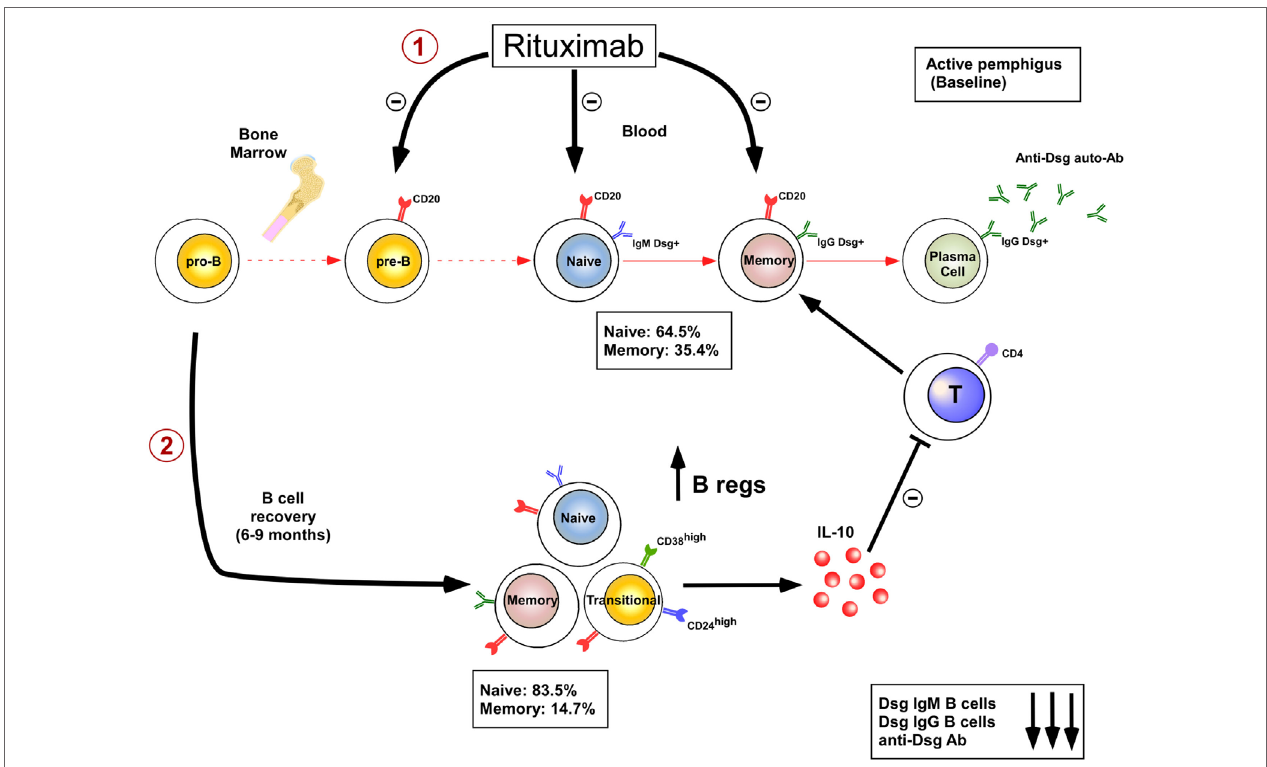
FiGURe 1 | Dual mechanisms of B cell depletion: 1: elimination of autoreactive B cells; 2: induction of regulatory B